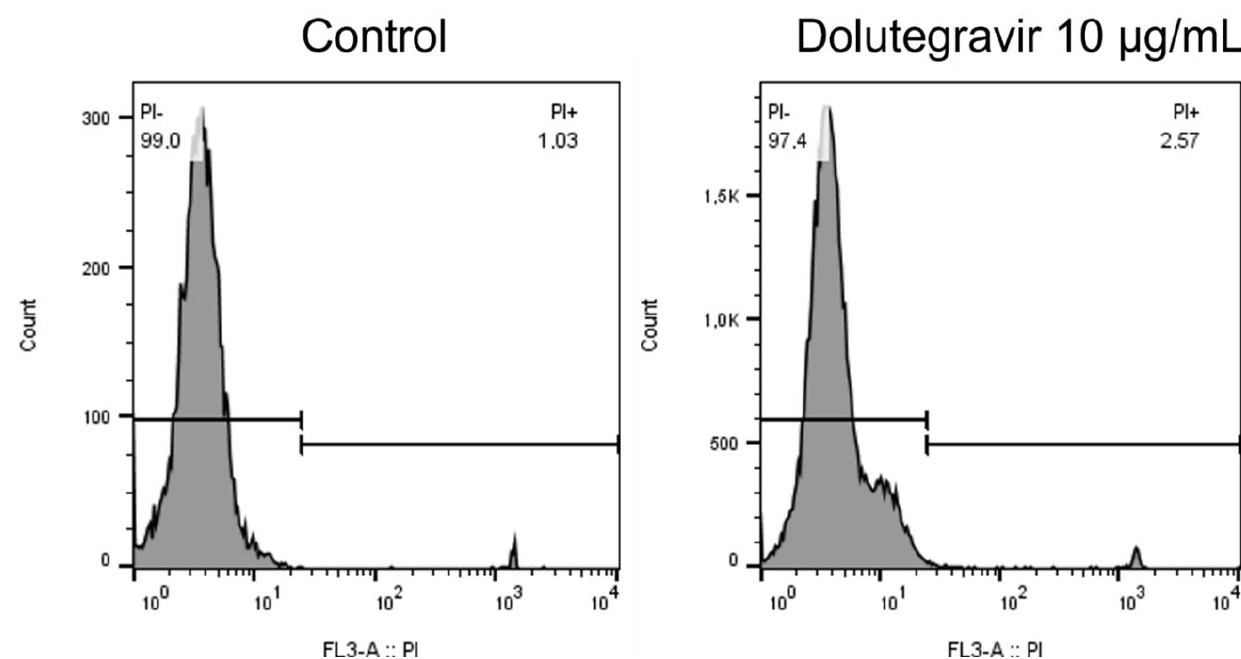
Figure 4. Cell viability is comparable between the control and dolutegravir-treated cells.